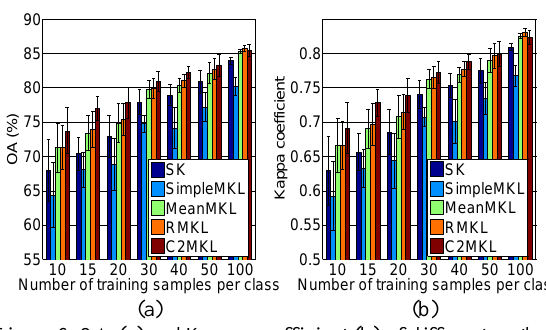
Figure 6. OA (a) and Kappa coefficient (b) of different methods on Recology data